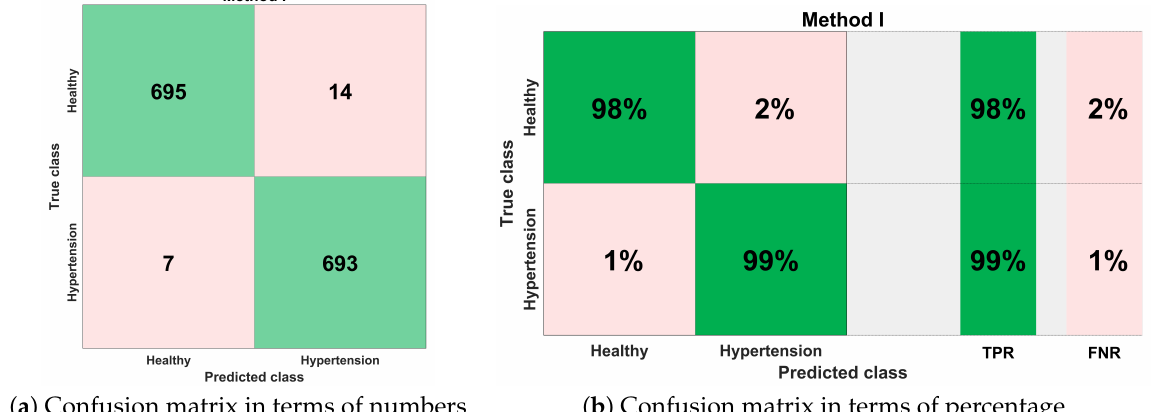
Figure 14. Confusion matrix for method I.